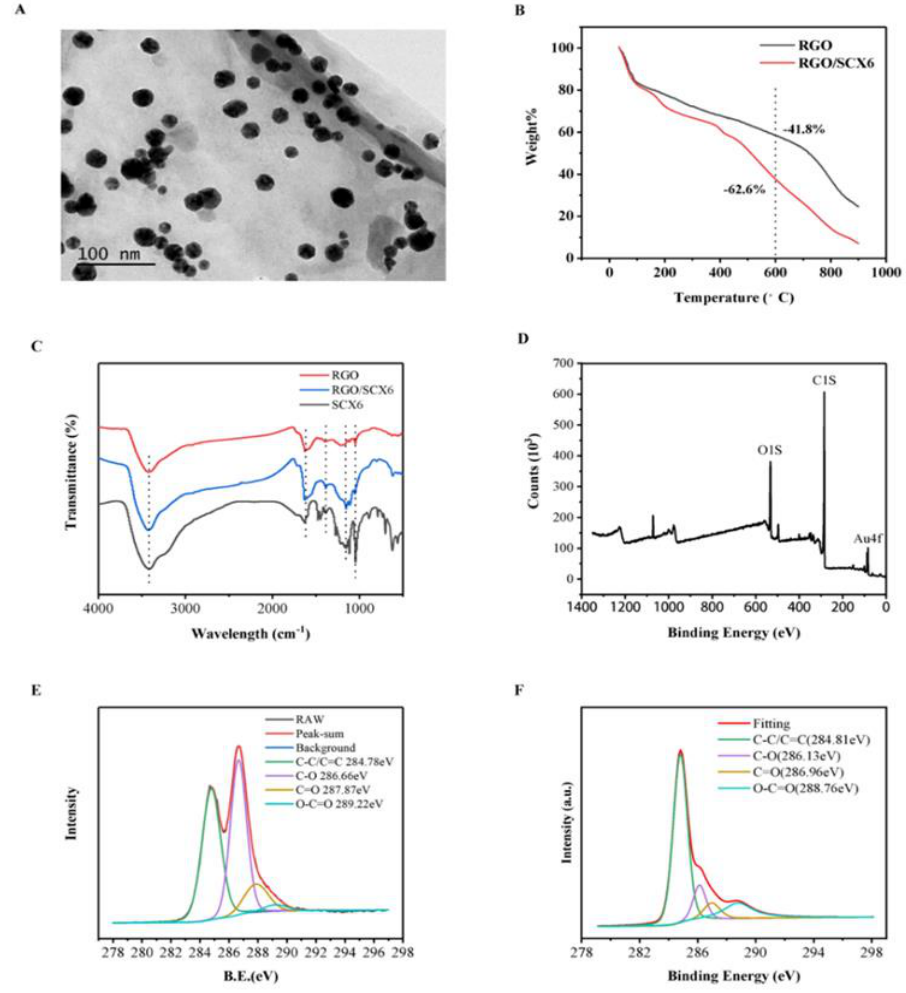
Figure 2. Characterization of nanocomposites ( A ) TEM image of Au/SCX6/RGO. ( B ) TGA curves of RGO and RGO/SCX6. ( C ) FT-IR spectra of RGO, SCX6, and RGO/SCX6. ( D ) XPS pattens of Au/SCX6/RGO. ( E ) XPS patterns of C1s in RGO. ( F ) XPS pattens of Au/SCX6/RGO.